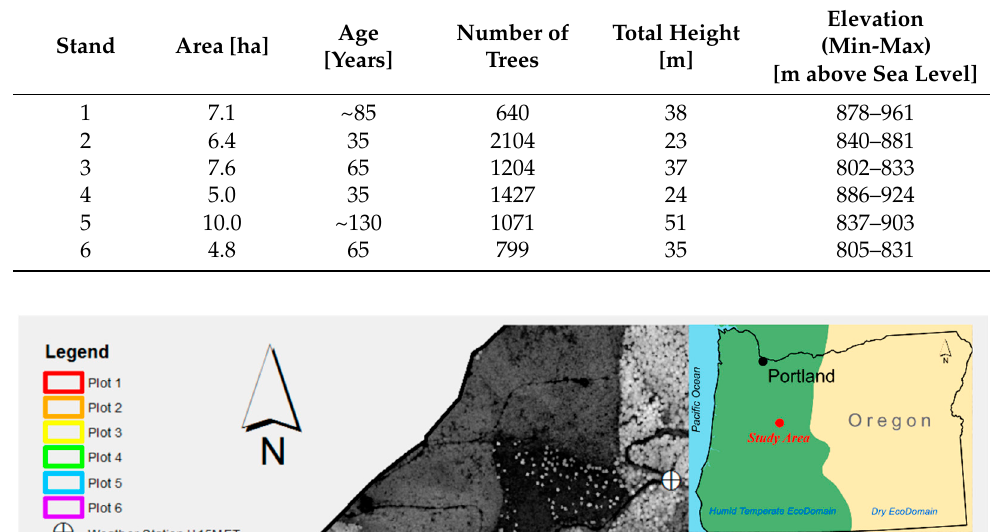
Table 1. Summary statistics of the study areas.